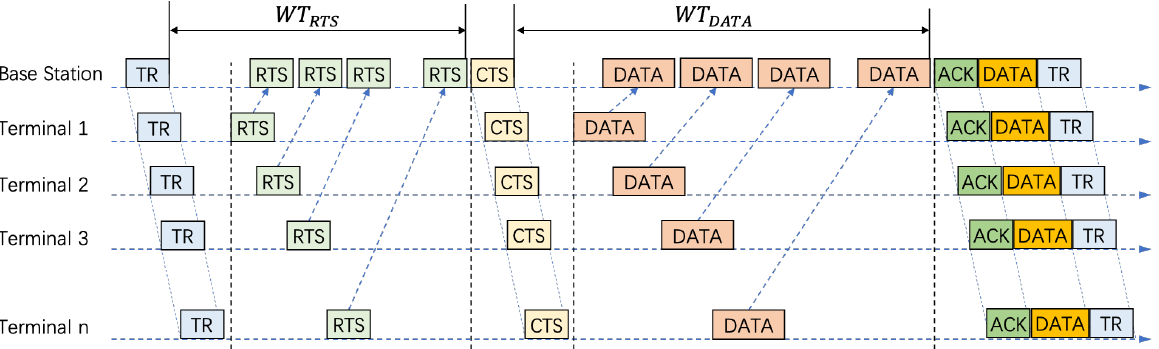
Figure 4. Scheduling diagram of